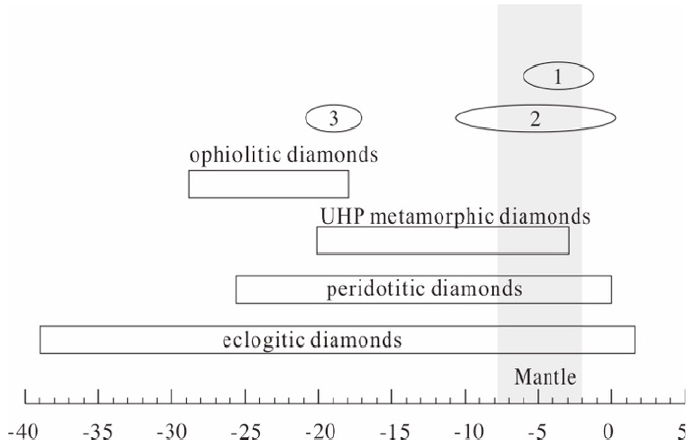
Figure 7. Comparative Column of δ 13 C values (modified from Cartigny (2005)). 1 -Macro-diamonds from North China Craton; 2 -Macro-diamonds from Yangtze Craton; 3 -microdiamonds in Alkalic dolerites